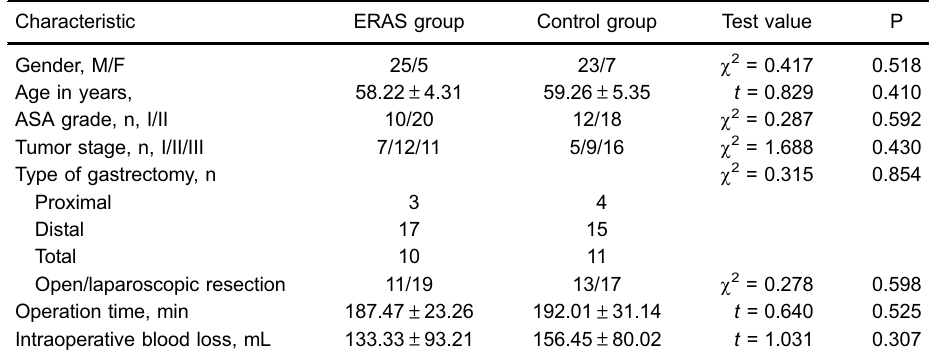
Table 2. Comparison of baseline characteristics and surgical conditions between the two groups of patients.